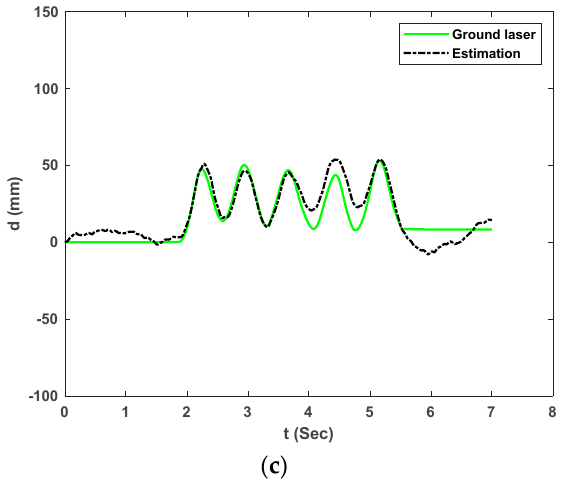
Figure 14. UAS measurement versus the ground laser of the moving board for experiment 5: ( a ) First car displacement estimation; ( b ) Eleventh car displacement estimation; ( c ) Tenth car displacement estimation.